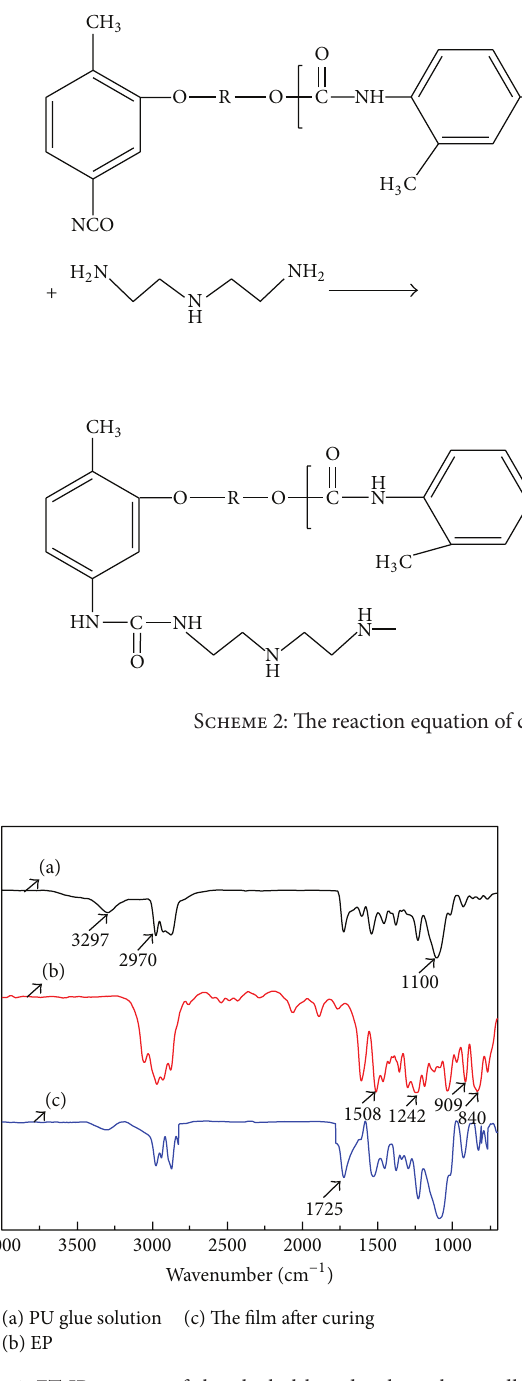
Figure 1: FT-IR spectra of the alcohol-based polyurethane adhe-